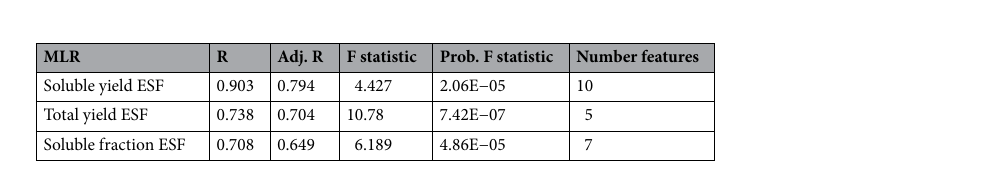
Table 4. Summary statistics of ESF multiple linear